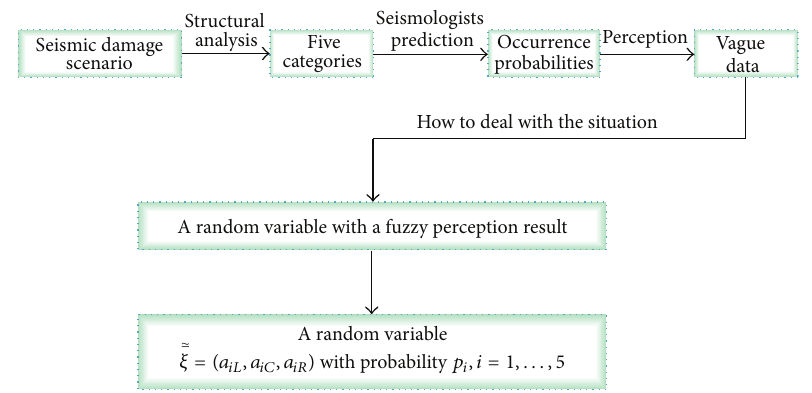
Figure 2: Fuzzy random seismic damage